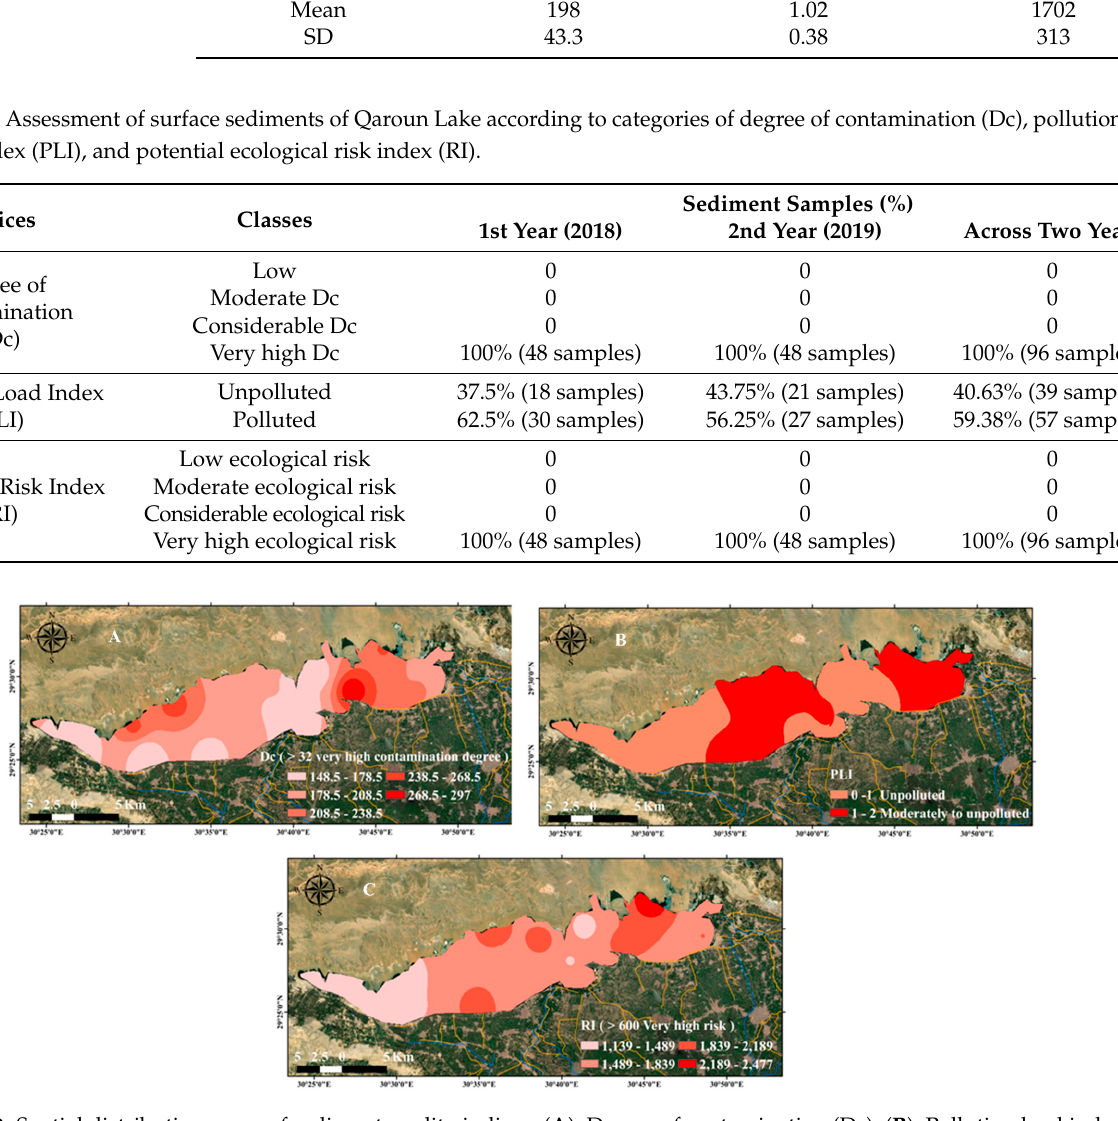
Figure 3. Spatial distribution maps of sediment quality indices: ( A ) Degree of contamination (Dc); ( B ) Pollution load index (PLI); and ( C ) potential risk index (RI) in the year 2019. 3.3. Correlation Matrix. Pearson correlation coefficient analysis shown in Figure 4 showed a strong positive correlation of Cd, Cr, Cu, Fe, Pb, Ni, Co, Li, Hf, Zr, Ba, and Mn with Al (r = 0.76, 0.73, 0.71, 0.8, 0.54, 0.75, 0.61, 0.65, 0.83, 0.64, 0.64, and 0.51 respectively) and Sb, Cd, Cr, Cu, Pb, Zn, Ni, Co, Li, and Hf with Fe (r = 0.63, 0.89, 0.84, 0.92, 0.60, 0.82, 0.83, 0.81, 0.67, 0.89 respec- tively); as well as Cr, Co, Ba, Zr, and Ga with Mn (r = 0.63, 0.53, 0.67, 0.74, 0.53 respectively) and Sb, Cd, Cr, Cu, Pb, Zn, Ni, Co, and Zr with Hf (r = 0.51, 0.89, 0.91, 0.93, 0.65, 0.77, 0.89, 0.79, 0.68 respectively). Another significant relation of Zn with Sb (r = 0.66), Cd (r = 0.74),